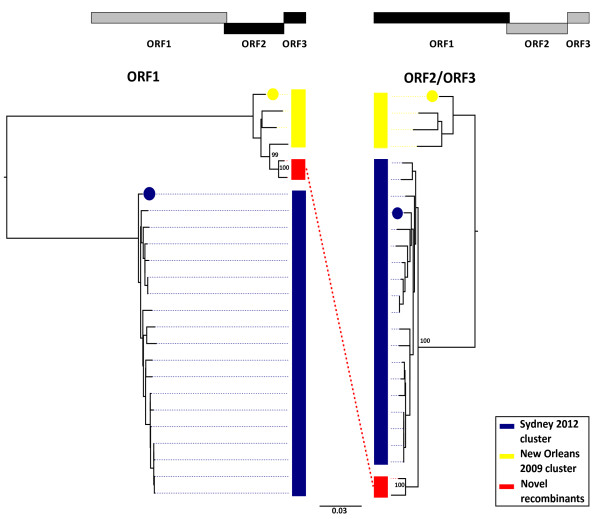
Norovirus phylogenies for ORF1 and ORF2/3. Maximum likelihood trees for ORF1 and ORF2/ORF3 regions based on an alignment of 23 norovirus sequences from England and Jersey isolated during winter 2012/13 and two GII.4 reference genomes: New Orleans 2009 and Sydney 2012 (represented with yellow and blue filled circles, respectively). Trees were constructed in PhyML (27) under an HKY85 model of nucleotide substitution, midpoint rooted and bootstrapped with 100 replicates. The bootstrap support is provided for each node (in bold). Clades are coloured according to the reference strain with which they appear to cluster. The dashed line highlights phylogenetic incongruity between ORF1 and ORF2/ORF3, proposed to have arisen by recombination.